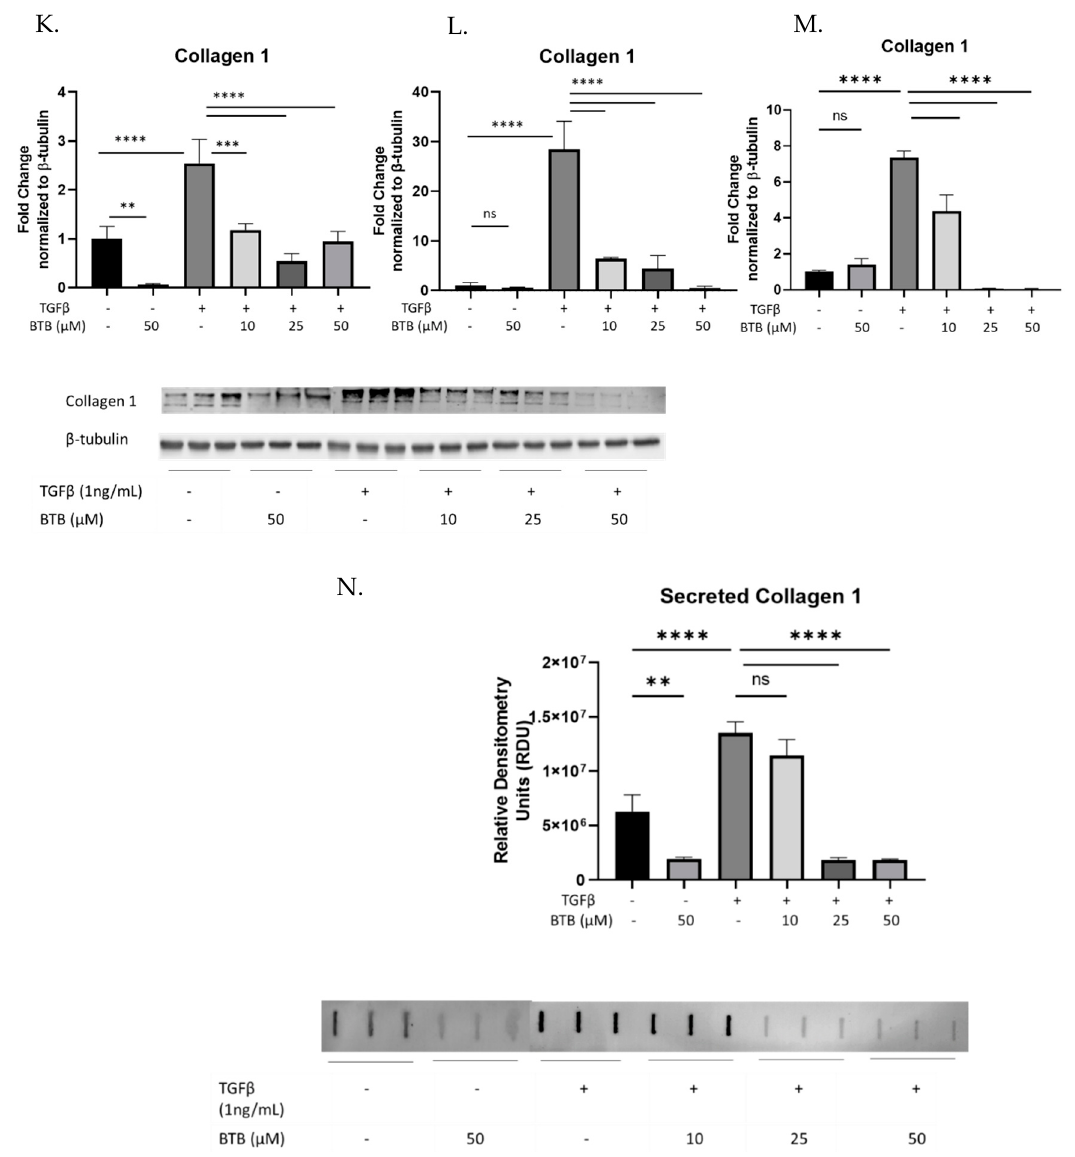
Figure 4. BTB prevents matrix protein production mediated myofibroblast differentiation in non- fibrotic and IPF-derived fibroblasts. Non-fibrotic and IPF-derived primary human fibroblasts were treated with the indicated dose of BTB and/or 1 ng/mL TGF β for 72 h before protein was harvested. Each graph represents an individual donor, and all experiments were performed with three non- fibrotic and three IPF-derived cell lines. Non-fibrotic and IPF fibroblasts were examined for the expression of fibronectin ( A – C and D – F ). Collagen protein expression was examined in protein lysates and supernatants from non-fibrotic fibroblasts ( G – J ) and IPF derived fibroblasts ( K – N ). Data were analyzed by ANOVA. n = 3 technical replicates/group. * p < 0.05, ** p < 0.01, *** p < 0.001, **** p < 0.0001, ns= not statistically significant. Note for gels exceeding 15 samples that the first six lanes of each blot were run separately due to the lane capacity of the gel.